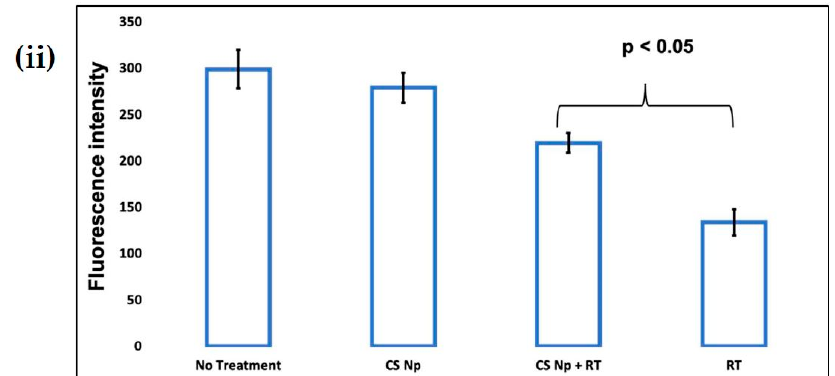
Figure 7. The effect of CS Np on rotenone insult determined using rhodamine 123 dye. ( i ) Cells were incubated with rhodamine 123 and the mitochondrial membrane potential was monitored using a fluorescent microscope for ( A ) untreated, ( B ) CS Np 20 µM, ( C ) 20 µM Chitosan powder + RT, and ( D ) 50 µM RT; ( ii ) quantification of Mitochondrial membrane potential assay under previously described conditions. Each experimental point was assessed in triplicate. The scale bar in the image is 50 µm.